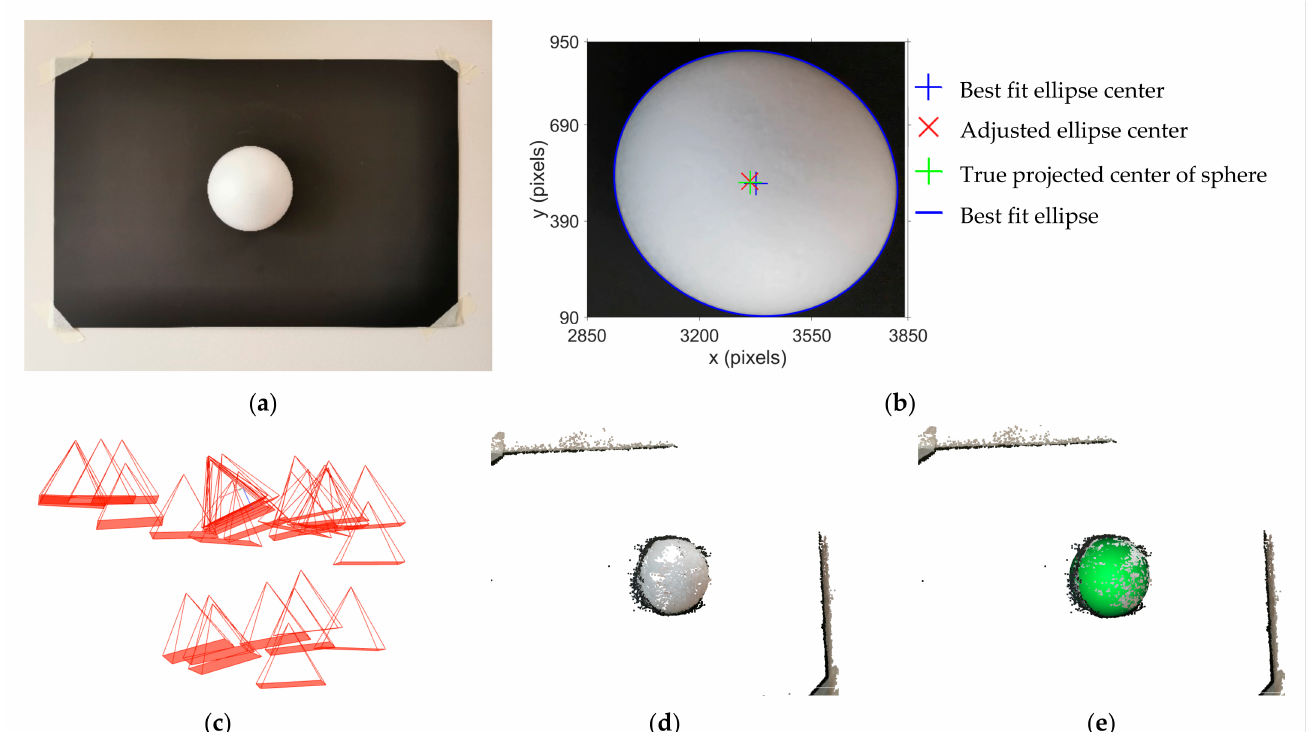
Figure 2. ( a ) Spherical target with black background; ( b ) best fit ellipse, its center and the corrected center using Algorithm 1 for the image of the spherical target; ( c ) plan-view of the estimated position and orientation of each image; ( d ) dense 3D reconstruction of the spherical target; and ( e ) robust best fit sphere (shown in